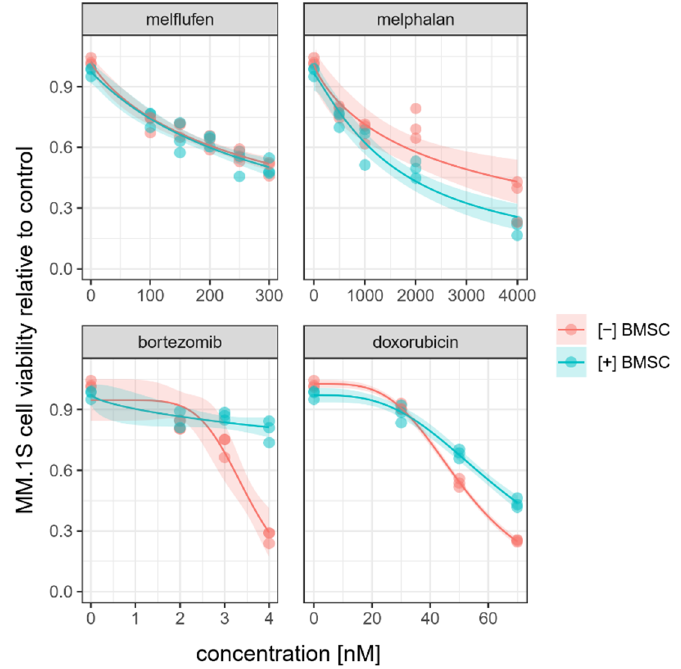
Figure 3. Effect of BMSCs on cytotoxic response of myeloma cells to drugs. Relative viability of MM.1S myeloma cells after 72 h of culture in the presence of melflufen, melphalan, bortezomib, and doxorubicin in the presence (blue) or absence (red) of BMSCs in indirect co-cultures. Results are shown from a single experiment out of the three experiments run in total with different BMSC donor cell lines. Dots represent individual culture wells. Dose–response curves are flanked by confidence intervals indicated in gray.